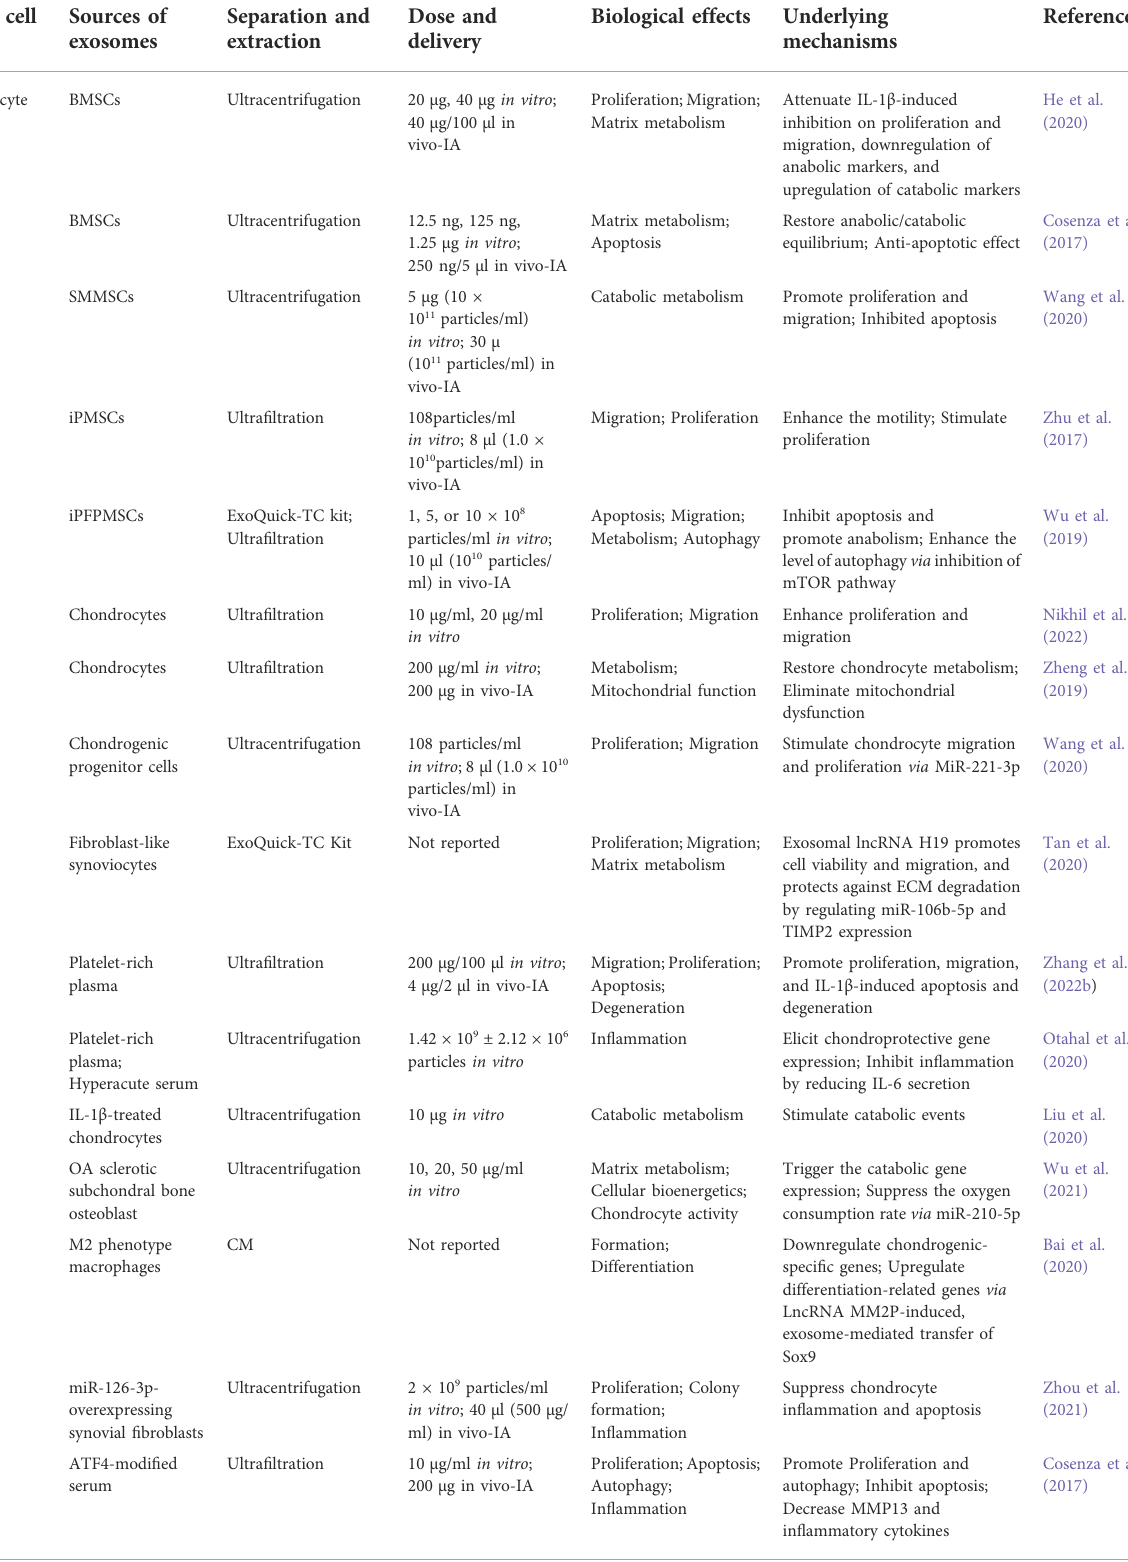
TABLE 2 Summary of Roles of Exosomes on Different Target cells in